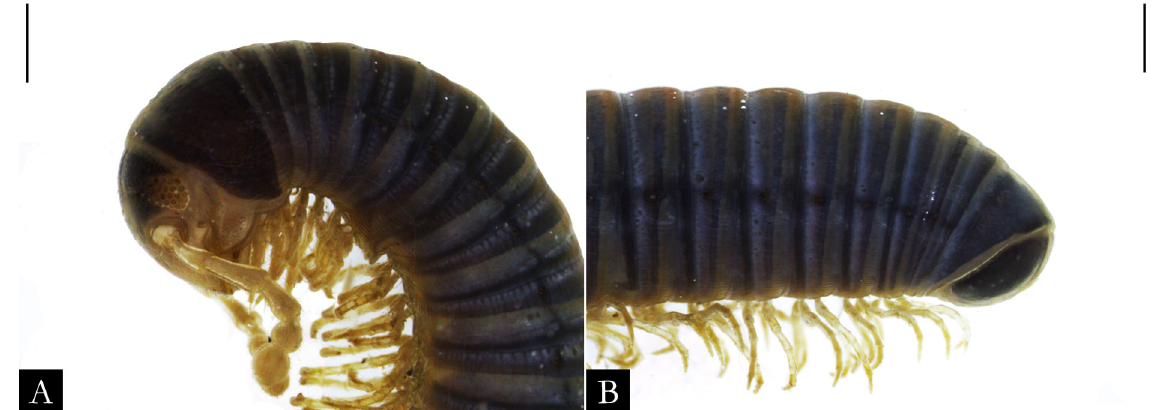
Fig. 111. Pseudonannolene pusilla Silvestri, 1895, ♂ (IBSP 13390), in lateral view. A . Anterior region. B . Posterior region. Scale bars = 0.5